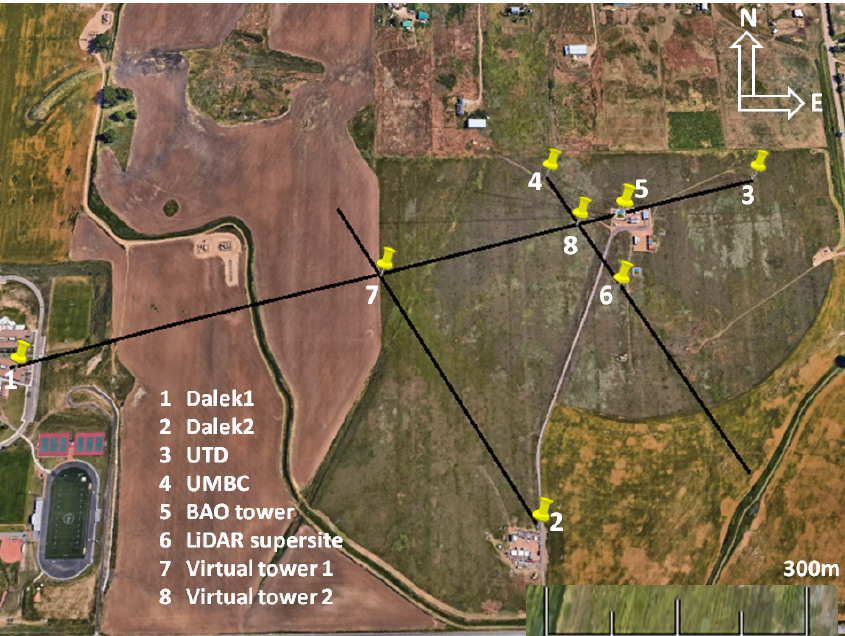
Figure 1. Map of the setup for the triple RHI scans performed during the XPIA experiment at BAO. Locations of the four scanning Doppler wind lidars, the two virtual towers, wind lidar profilers (lidar supersite) and BAO tower are